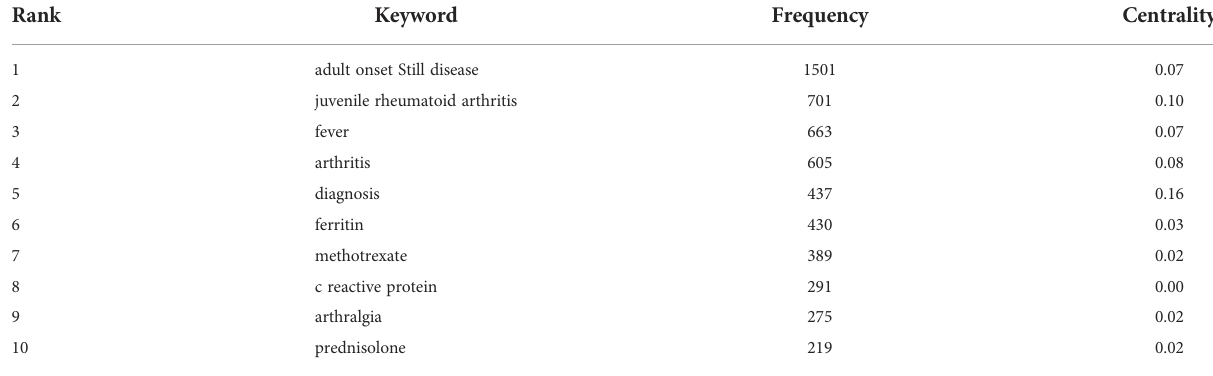
TABLE 6 High frequency keywords (>200) of adult-onset Still ’ s disease articles from 1921 to 2021. Rank